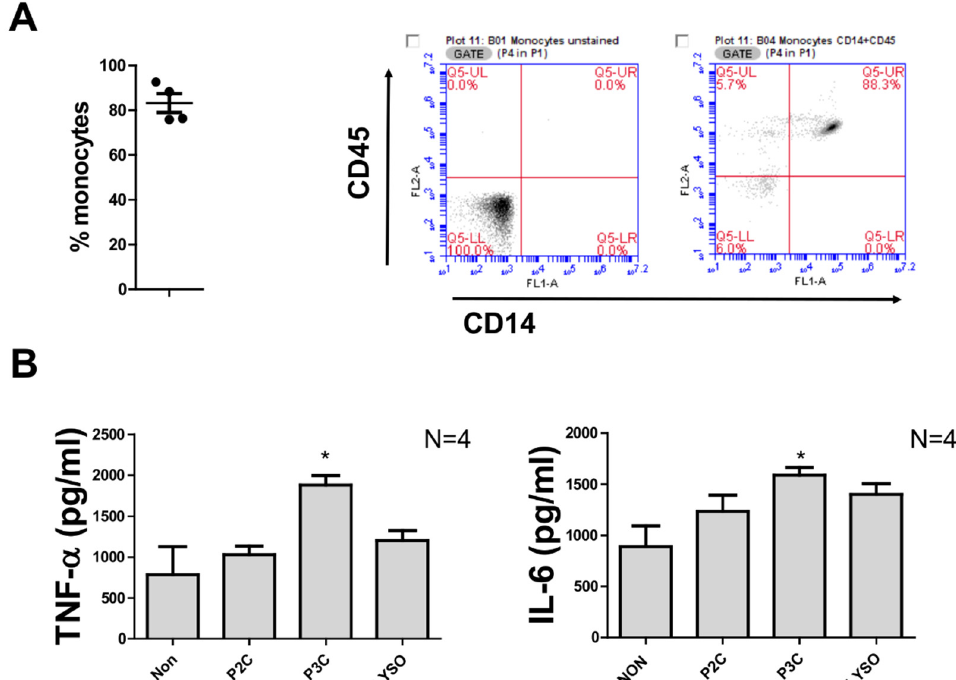
Figure 3. Cytokine production of pan monocytes isolation without resting. ( A ) Percentage CD14 + monocytes from purified pan monocytes. Cells were stained with CD14-FITC and CD45-PE antibodies. Data were obtained by flow cytometry from 4 donors. Flow cytometric analysis from a representative experiment with pan isolated monocytes unstained (left) and stained (right) with CD14-FITC and CD45-PE antibodies. ( B ) The 10 5 monocytes were stimulated with 100 ng/mL of P2C, P3C, or Lyso. The control samples (non) were used without adding any stimulators. TNF values were measured by ELISA from supernatant of 5 h stimulation, and IL6 and IL-10 were measured by ELISA from supernatant of 18 h stimulation. Samples from 4 donors were analysed in triplicate. Error bars represent the SEM. Statistical significances were calculated between the treated cells compared to control (non) by using Kruskal–Wallis test: * p < 0.05,.